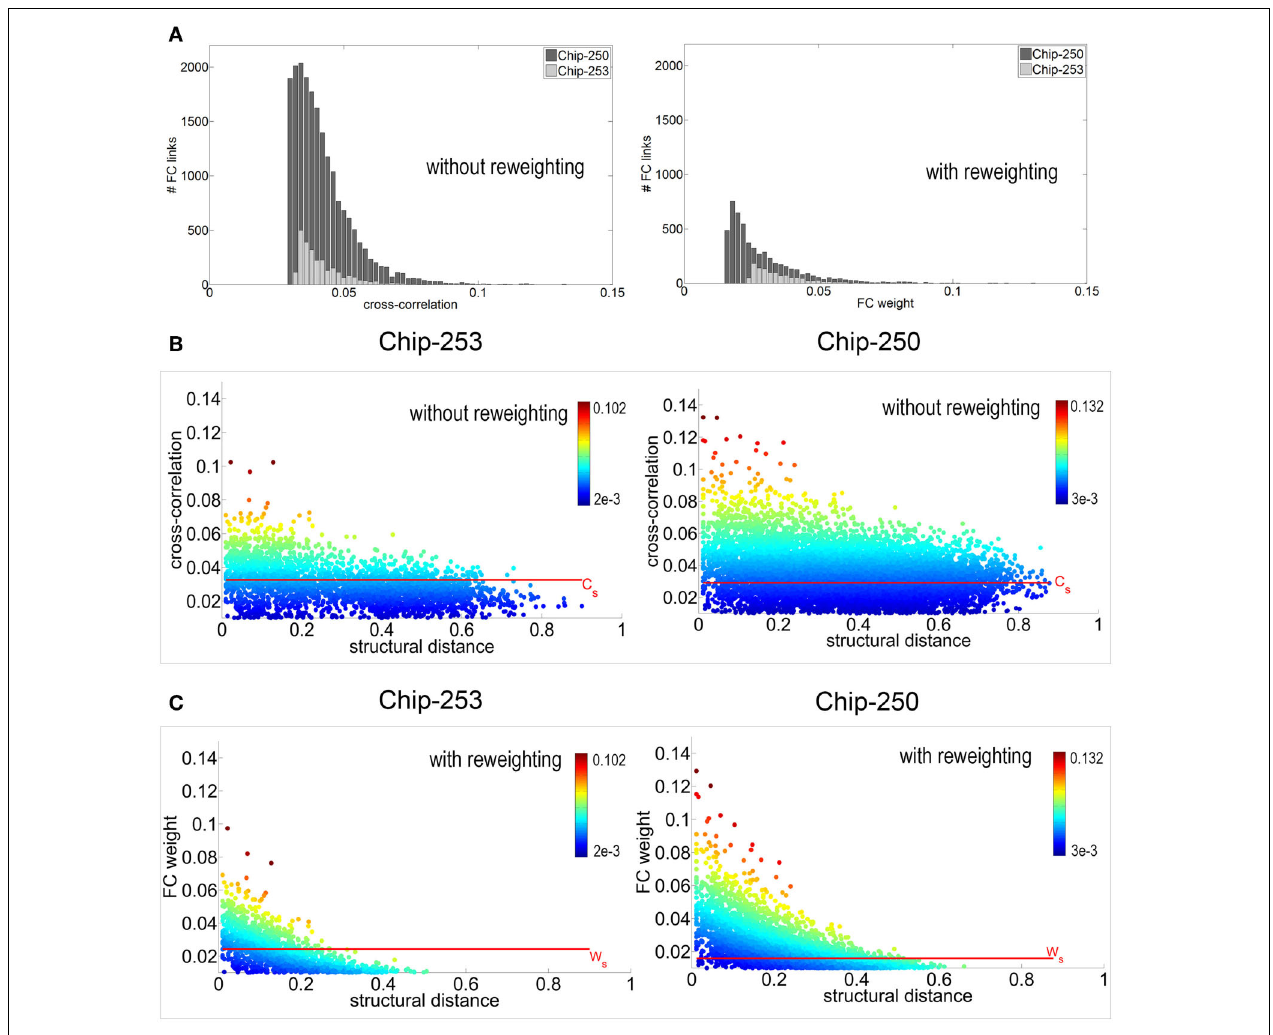
FIGURE 7 | (A) Distribution of functional weights before and after reweighting. (B) Weight vs. distance plot before reweighting. Points are color-coded with a heat colormap based on the correlation value. The significance threshold C s is computed using a statistical test with p -value